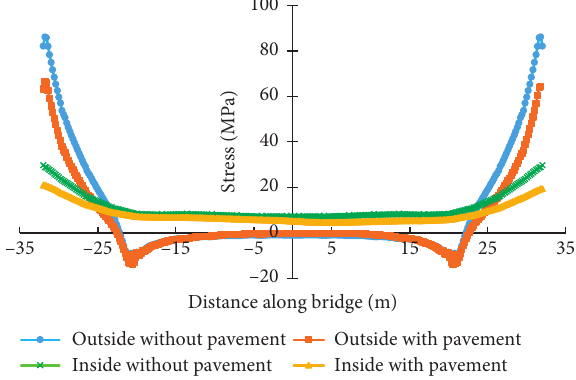
Figure 11: Impact of the pavement layer to steel box girder